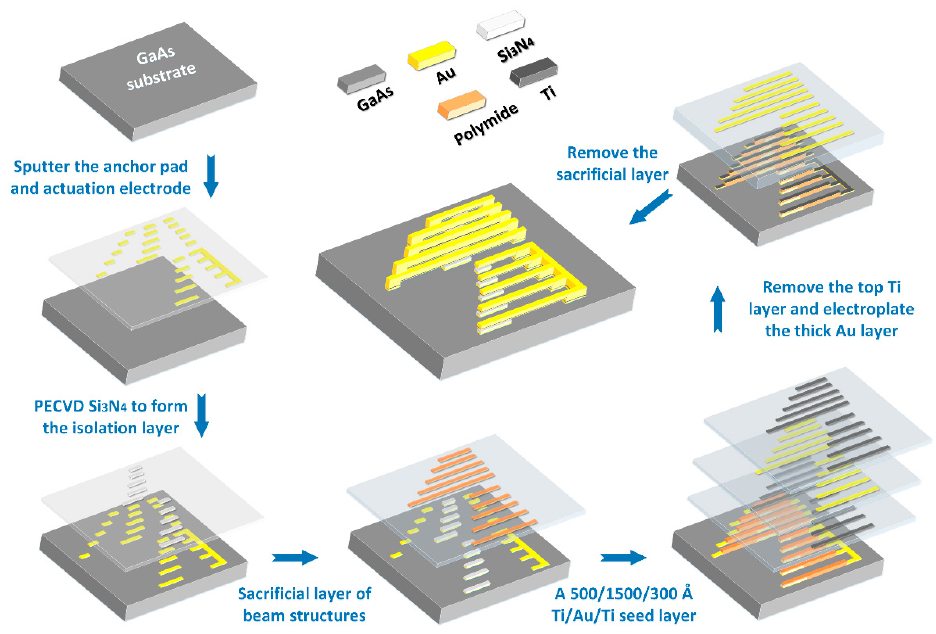
Figure 3. Processing steps of GaAs MMIC-based MEMS beams: the processing sequence is listed in the order of blue arrows.